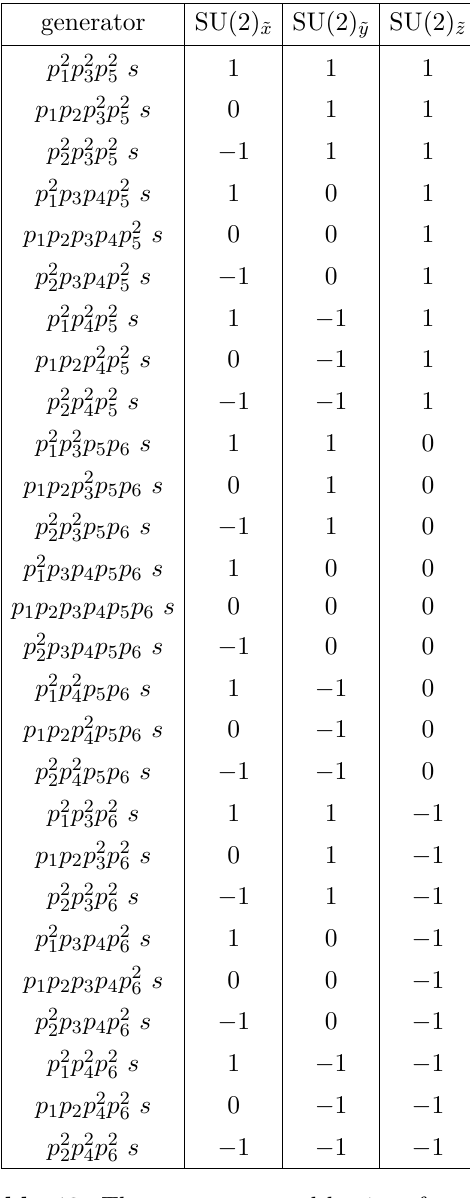
Table 48 . The generators and lattice of generators of the mesonic moduli space of Model 12 in terms of brick matchings with the corresponding flavor